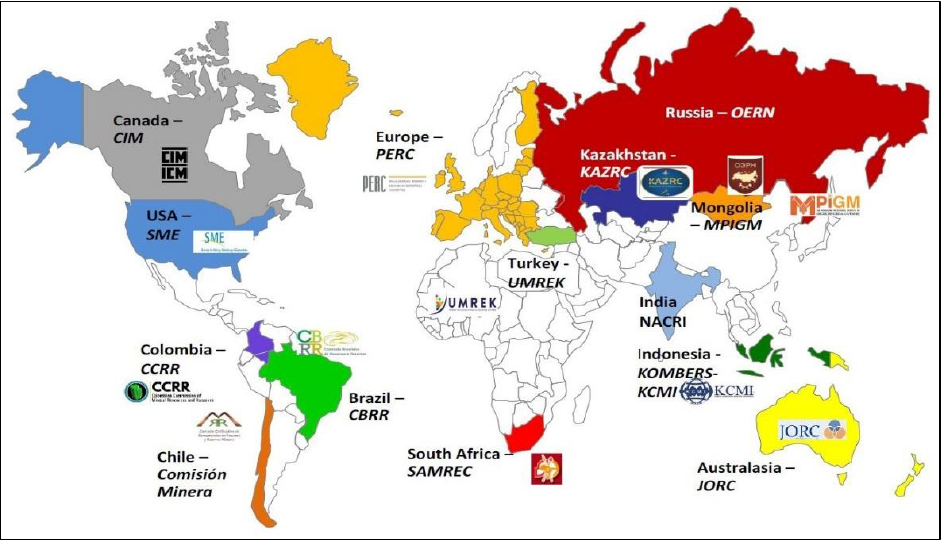
Figure 3. Map of member coders Committee for Mineral Reserves International Reporting Standards (as of August 2019). Source: Committee for Mineral Reserves International Reporting Standards [16].